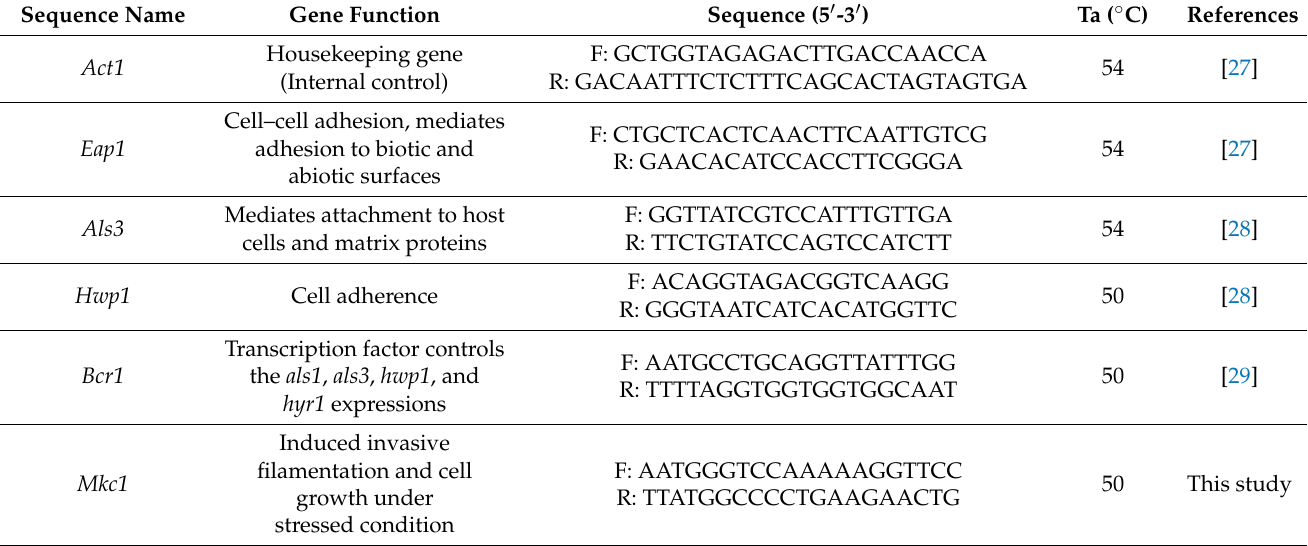
Table 1. Primers and their sequences used in this